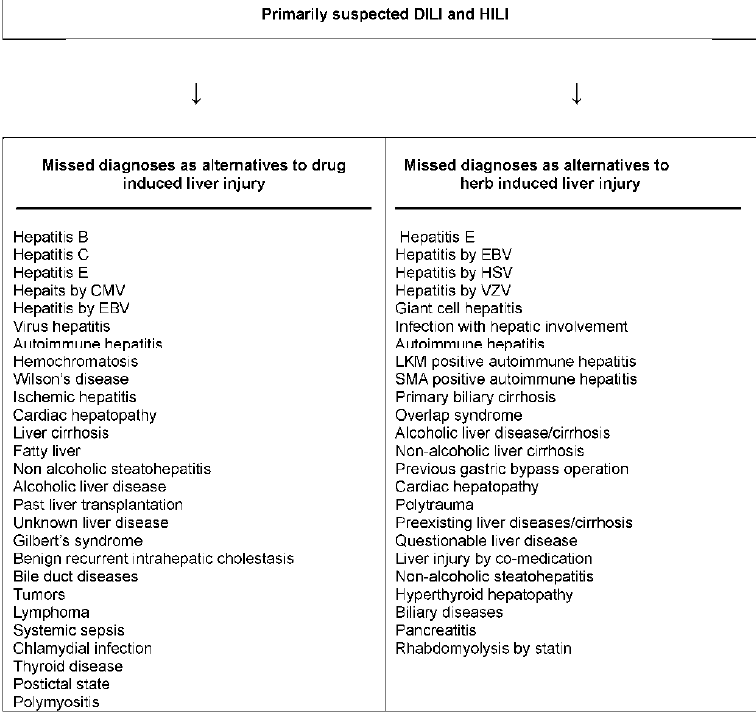
Figure 2. Missed diagnoses in cases of initially suspected hepatotoxicity by synthetic drugs or herbs. Adapted from previous reports [31,32], which provide the respective references for each missed diagnosis listed above. Abbreviations: CMV, Cytomegalovirus; EBV, Epstein Barr virus; HSV Herpes simplex virus; LKM, Liver kidney microsomes; SMA, Smooth muscle antibodies; VZV, Varicella zoster virus.